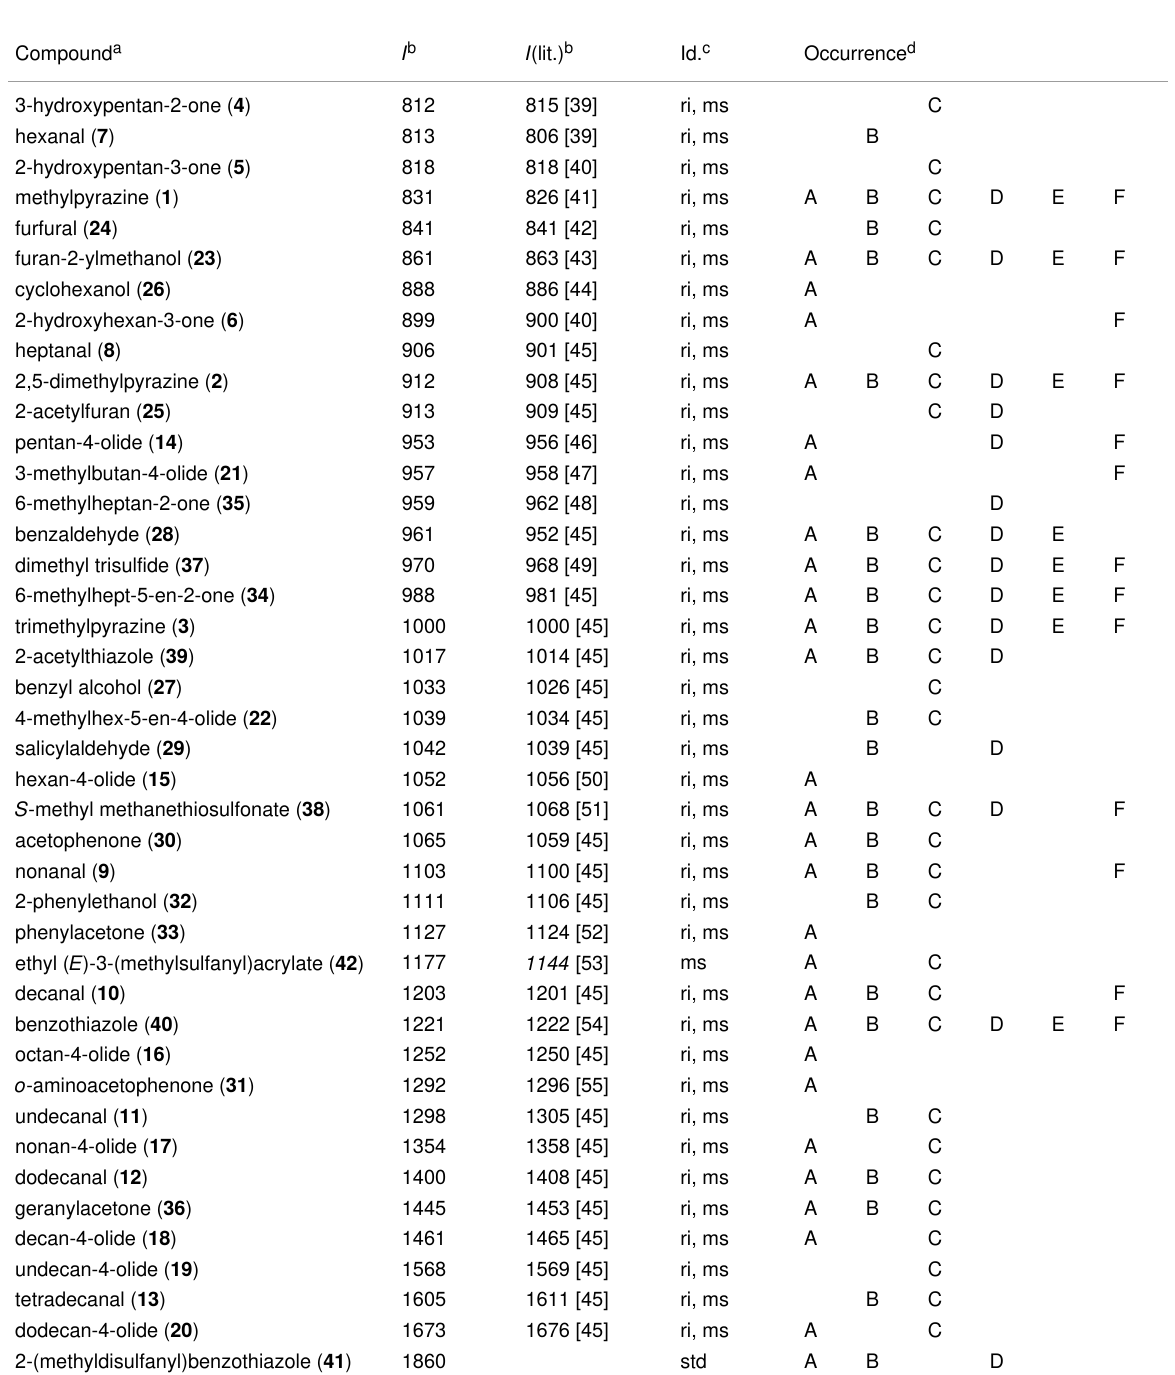
Table 1: Volatiles from Celeribacter